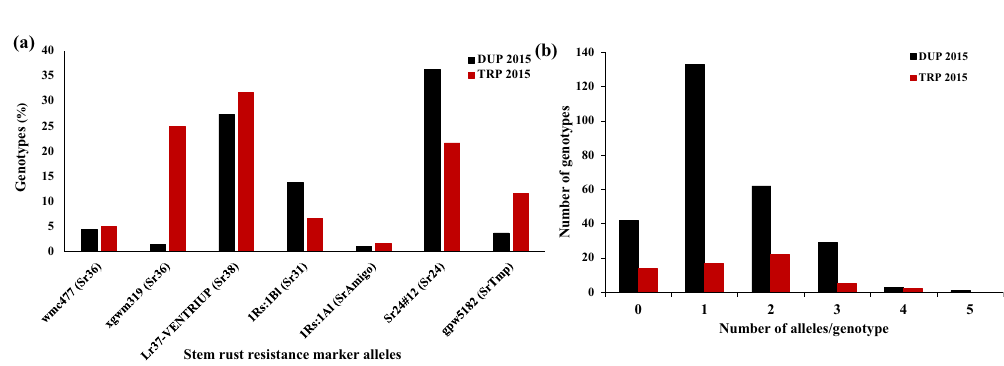
Figure 2. ( a ) percentage of genotypes having stem rust alleles in DUP and TRP populations and ( b ) Number of genotypes which having different stem rust alleles in both